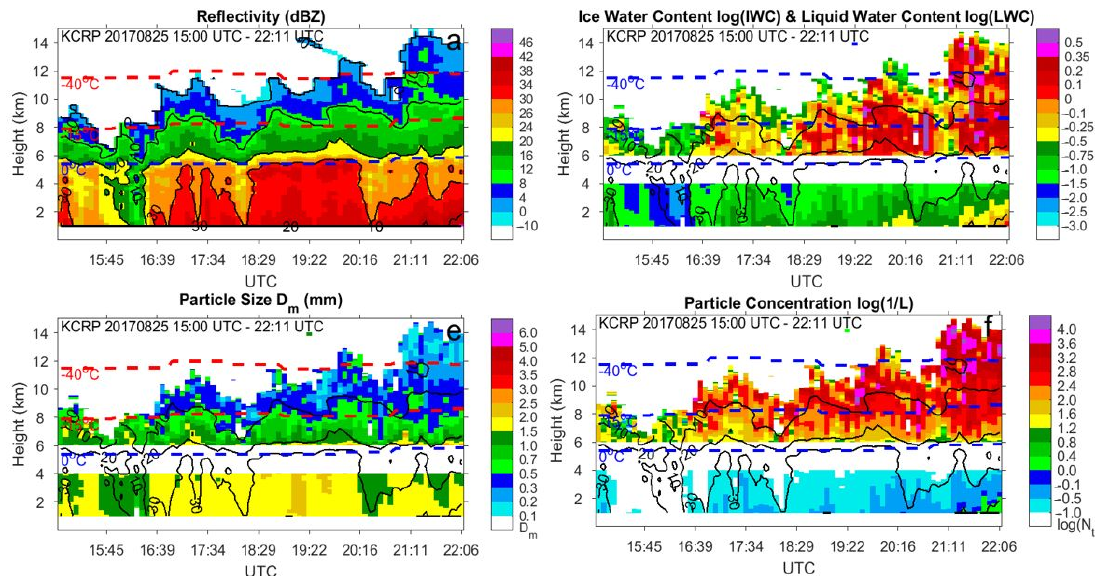
Figure 16. Columnar vertical profiles (CVPs) of Z H , IWC/LWC, D m , and N t in the eyewall of hurricane Harvey from the perspective of the KCRP WSR-88D radar in Corpus Christi. The location of the column base is shown with the white rectangle in Figure 7 (left panel). Overlaid are contours of Z H every 10 dBZ.